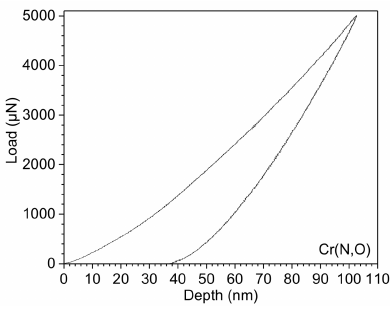
Figure 6. Typical force–displacement curves of Cr(N,O) coating.